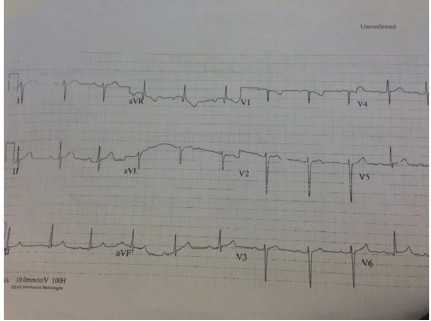
Figure 2: EKG revealing sinus rhythm at a rate of 65 bpm with first- degree AV block and left anterior hemiblock.